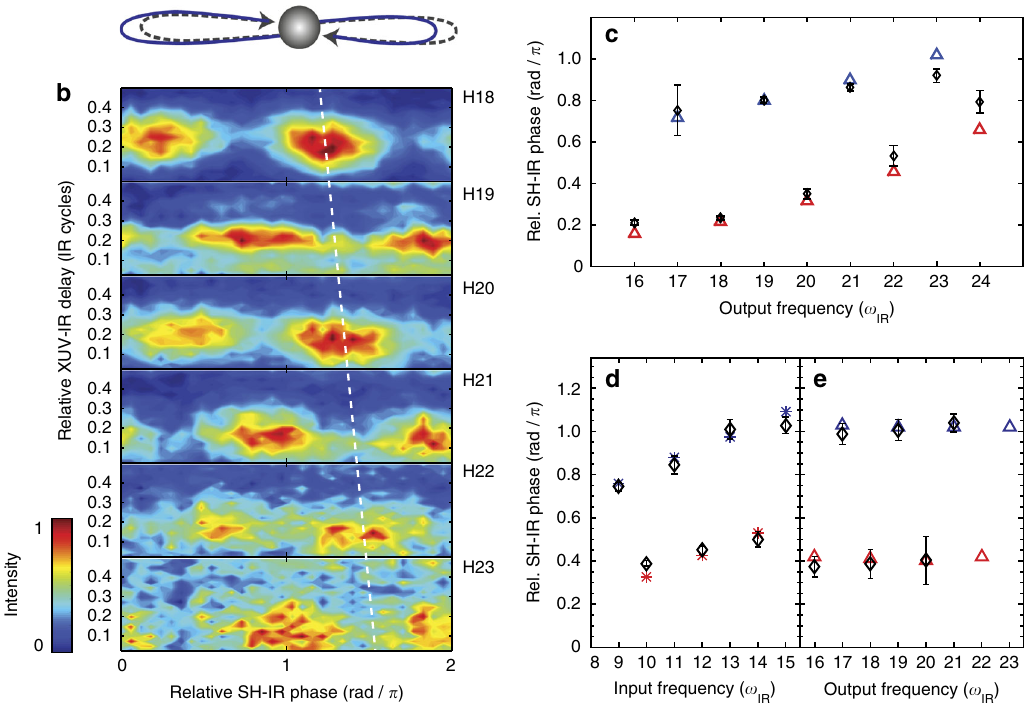
Fig. 3 Perturbative probing of the XUV-initiated HHG dynamics. a Illustration of symmetry breaking between consecutive electron trajectories. For a speci fi c SH-IR delay, the symmetric picture (dashed line) is broken: in one IR half cycle (right), the electron trajectory is shorter than in the consecutive half cycle (left). b Probing of the strong- fi eld interaction. Normalized intensity of XUV-initiated harmonics as a function of both SH-IR phase and XUV-IR delay. Here the SH and IR pulses are synchronized in the target gas cell. In addition to XUV-IR delay-dependent oscillations, out-of-phase oscillations between odd and even harmonics are observed as a function of SH-IR phase. The white line is a guide to the eye to highlight the phase slope of the SH-IR oscillations of the even harmonics. c SH-IR phases that optimize the intensity of individual harmonics after integrating over the XUV-IR delay, for the experiment (black diamonds) and the Coulomb-corrected model (triangles). d Probing of the ionization step. Optimal SH-IR phases of the ionizing harmonics, when the SH and IR fi elds are synchronized in the source gas cell. The experimental results (black diamonds) show out-of-phase oscillations of odd and even harmonics throughout the entire spectrum. Both the odd and the even phase slopes follow the classical prediction (Eq. 2, stars). e Optimal SH-IR phases for XUV- initiated harmonics above the helium ionization threshold. The fl at-phase behavior is in good agreement with the Coulomb-corrected model (triangles). All error bars on experimental data correspond to standard